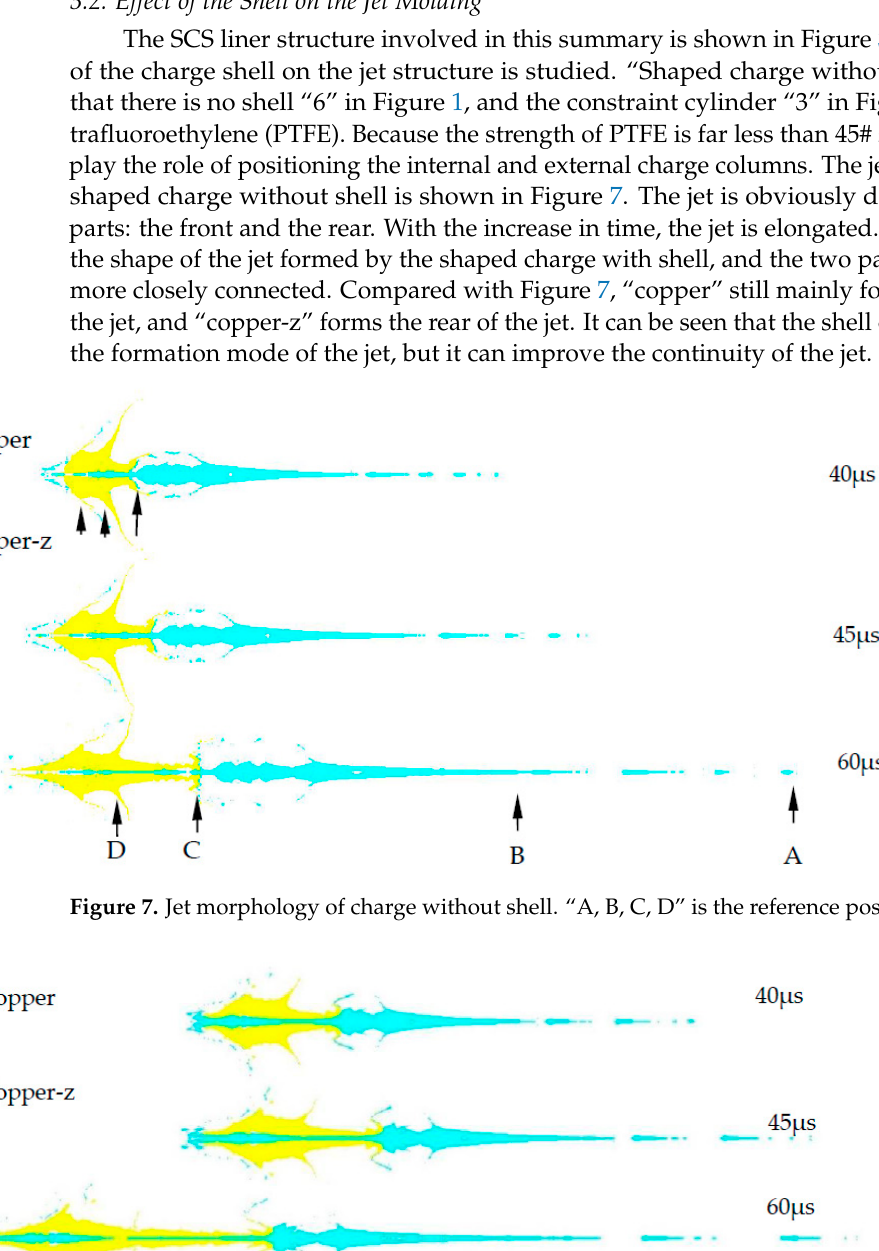
Figure 9. Variation curve of the continuous velocity of the explosive charge jet with the wall thick- ness of the constraint cylinder. Figure 10 shows the morphology of the jet when the constraint cylinder has different thicknesses. The wall thickness of the constraint cylinder corresponding to the jet is 0.9 mm to 2.9 mm from top to bottom. With the increase in the wall thickness of the constraint cylinder, the diameter of the jet protrusion decreases, and the part of the material in the spherical missing body forming the pestle body decreases.